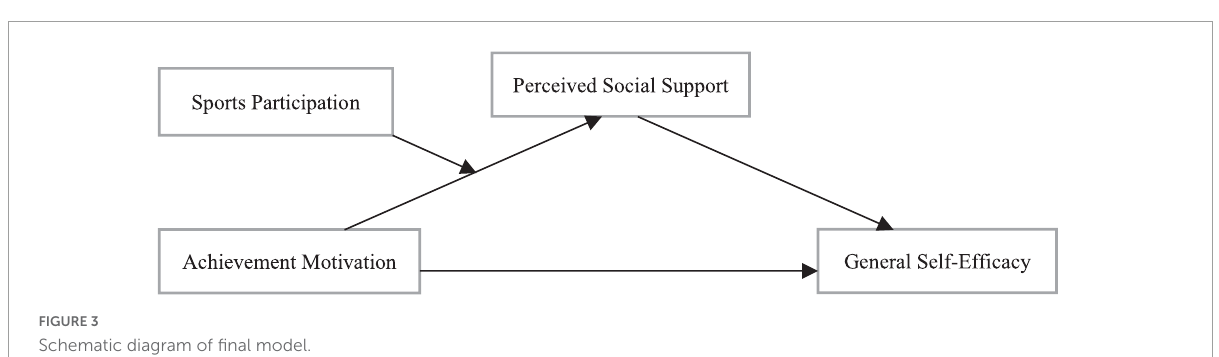
FIGURE3 Schematic diagram of final